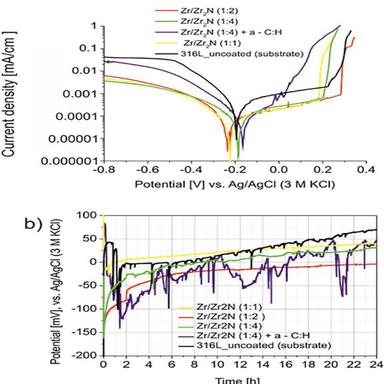
Corrosion testing was performed in Ringer's solution at a temperature (T) of 37 °C; a) potentiodynamic polarization curves with a potential scan rate of 1 mV/s; and b) the evolution of open circuit potential over time.